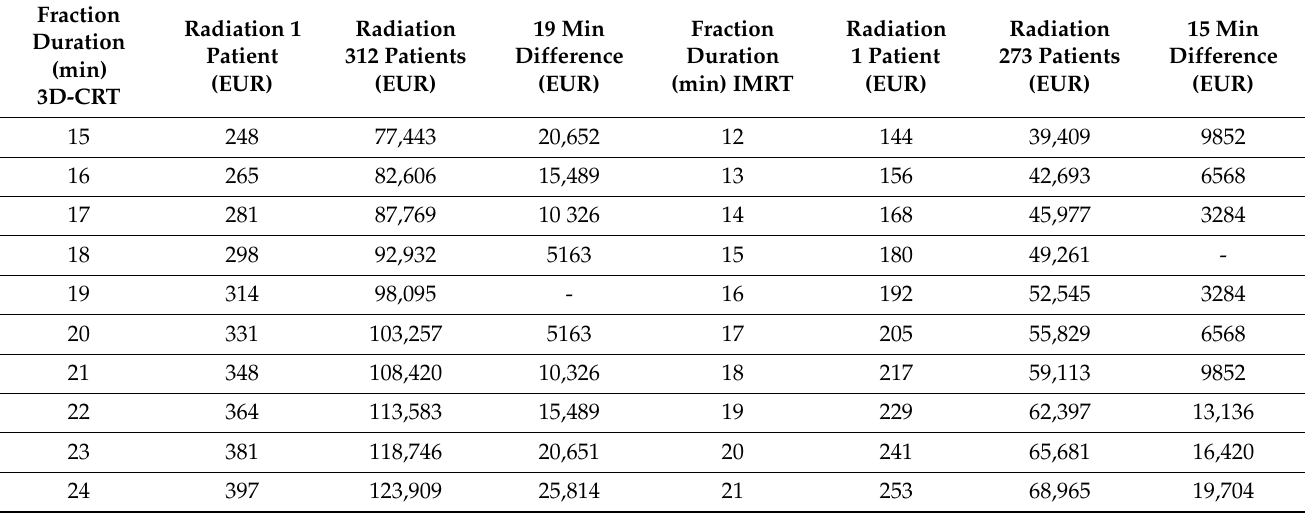
Table 14. Time modulation in relation to the A5